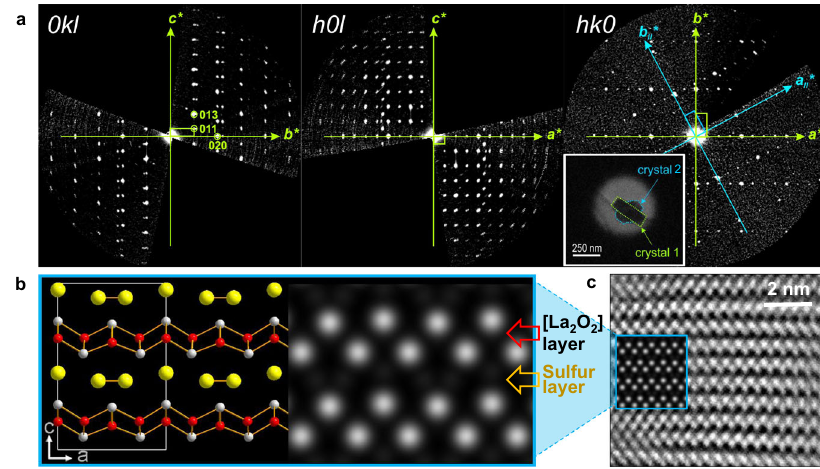
Fig. 4 Structure characterization of oA -La 2 O 2 S 1.5 . a Projection of the reciprocal space obtained from PEDT data following the indexing of the fi rst crystal (green). The second visible lattice (blue) corresponds to a second adjacent crystal and was measured in the same data set. b The structure of oA -La 2 O 2 S 1.5 solved and re fi ned from PEDT data set. The right side of the panel represents the simulated HAADF-STEM image along [010] on the basis of the oA - La 2 O 2 S 1.5 structure model. c The experimental HAADF-STEM image acquired in a well-organized domain oA -La 2 O 2 S 1.5 superimposed with the simulated